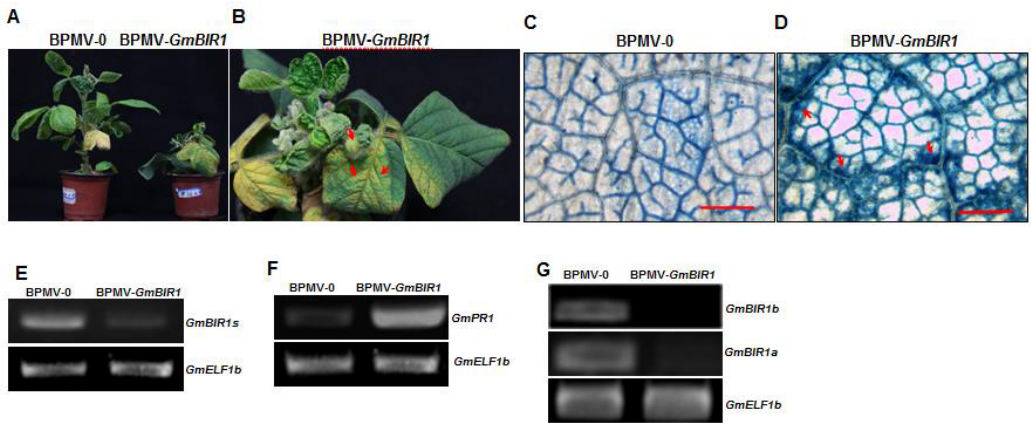
Figure 1. Silencing GmBIR1 causes both local and systemic hypersensitive response (HR) cell death in soybean. ( A ) The phenotypes of vector control (BPMV-0) and GmBIR1 -silenced (BPMV- GmBIR1 ) plants at 15 days post infection (dpi); ( B ) Massive cell death was observed on the systemic leaves of GmBIR1 -silenced plants at 25 dpi. Red arrows point to the dead leaves; ( C , D ) Trypan Blue-stained systemic leaves from vector control ( C ) and GmBIR1 -silenced plants ( D ). Red arrows point to the dead regions. Bar = 500 µ m; ( E ) RT-PCR result indicates that the GmBIR1 transcript level was reduced in GmBIR1 -silenced plants relative to the vector control plants; ( F ) RT-PCR result indicates that the GmPR1 transcript level was increased in GmBIR1 -silenced plants relative to the vector control plants; ( G ) RT-PCR result indicates that the GmBIR1a and GmBIR1b transcript level were both reduced in GmBIR1 -silenced plants relative to the vector control plants. Each experiment was repeated at least twice. Each experiment consisted of 3 replicates and at least 3 plants were used in each replicate.